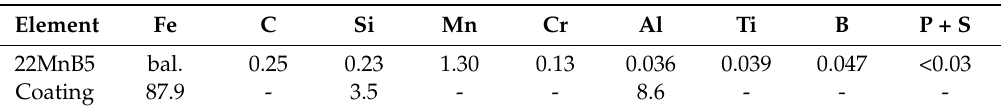
Table 1. Chemical composition of the hot stamping boron steel sheets (optical emission spectroscopy) and of the Fe/Al/Si coating (energy dispersive X-ray spectroscopy).